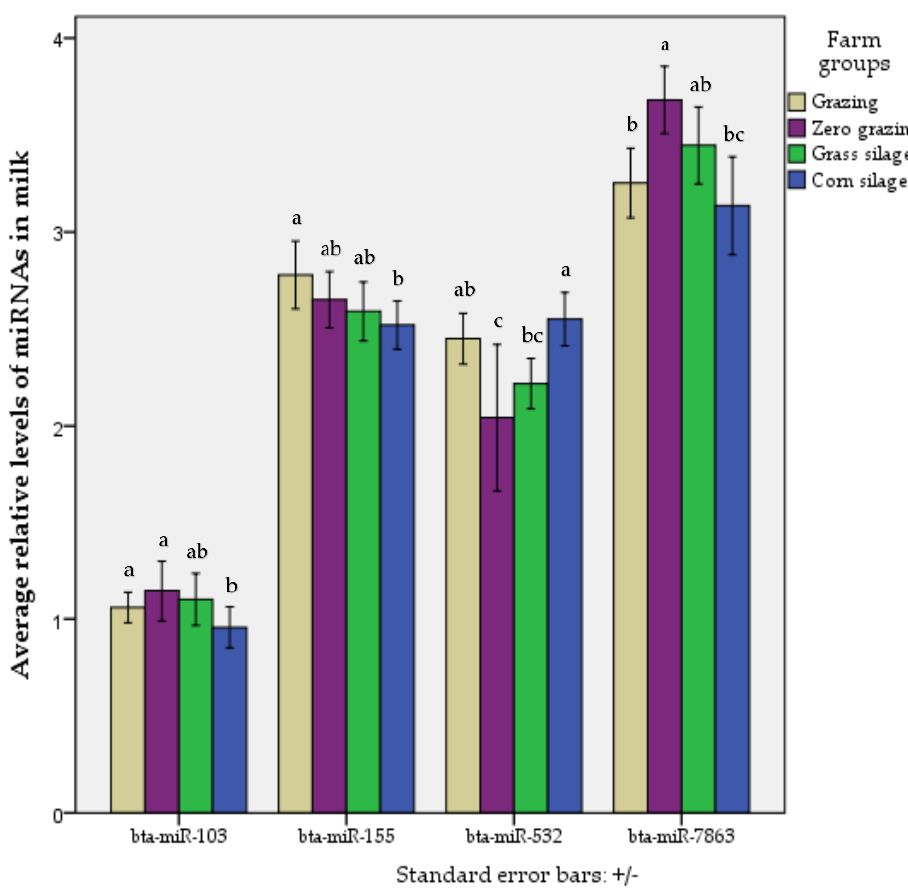
Figure 1. Average relative levels of the miRNAs bta-miR-103 , bta-miR-155 , bta-miR-532 , and bta-miR- 7863 in raw milk from grazing (n = 44), zero-grazing (n = 13), grass silage, (n = 10), or corn silage (n = 45) milk production systems. The bar chart shows the average of miRNA levels in each farm group, and the standard error bars. Different letters show significant difference between groups.